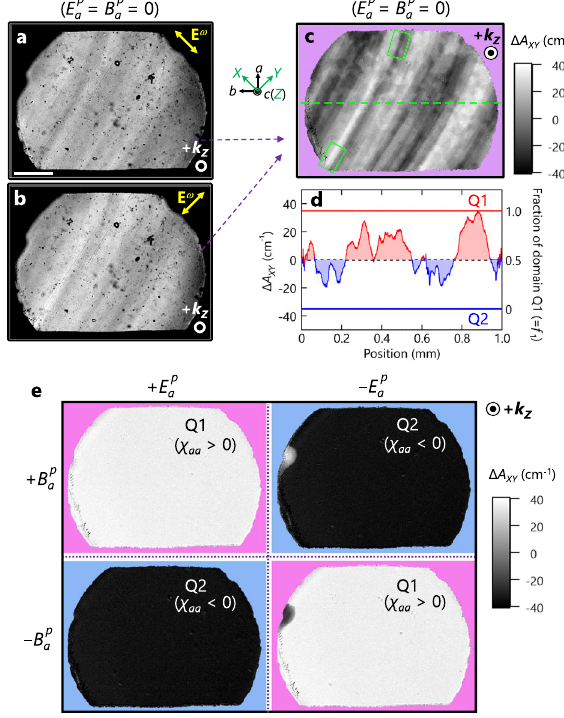
Fig. 5 Demonstration of optical imaging of magnetoelectric quadrupole domains. Microscopy images of a zero- fi eld-cooled sample taken at 5 K using the X - ( a ) and the Y - ( b ) polarized light propagating along the + Z direction. Scale bar, 200 μ m. c Linear dichroism ( Δ A XY ) image obtained by calculating logarithmic subtraction of the image in a from b . The presence of contrast indicates a multidomain state of Q1 and Q2. In the region of lower and upper green boxes, the angles between the domain boundaries and the a axis are about 30° and 16°, respectively. d Pro fi le of Δ A f XY (left axis) and the fraction of domain Q1, 1 , (right axis) along the green dashed line in c . The upper red (lower blue) line denotes a single domain state of Q1 (Q2). e Δ A XY images after cooling with four different sign combinations of poling fi elds ( E p a ¼ ± 0 : 57 MV m − 1 , B p a ¼ ± 0 : 1 T). The poling fi elds are removed before taking each image. The absence of contrast shows the single domain of Q1 (Q2) in the (anti)parallel con fi guration of E p a and B p a